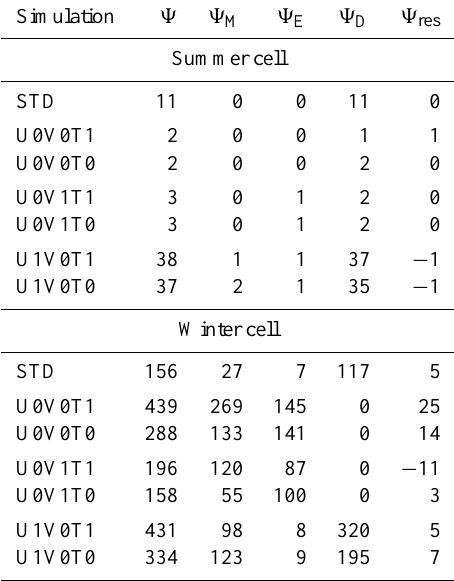
Table 2. Simulations with perpetual off-equatorial insolation and different treatment of vertical diffusion of momentum: strength of the winter and summer Hadley cell and decomposition into contri- butions from the mean circulation ( 9 M ), eddies ( 9 E ), and vertical diffusion 9 vdiff ). The attribution is based on Eq. (3) and accurate to within 5% of the cell strength as indicated by the residuum ( 9 res ). All values in units of 10 9 kgs − 1 .